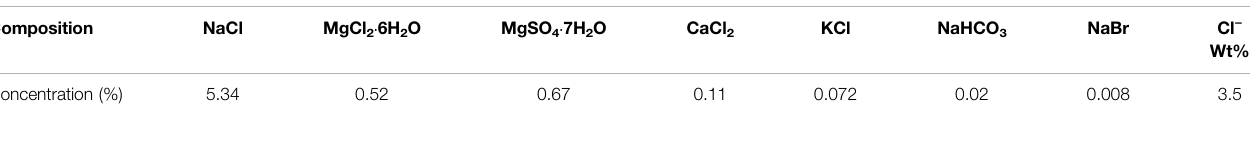
TABLE 2 | Composition of arti fi cial